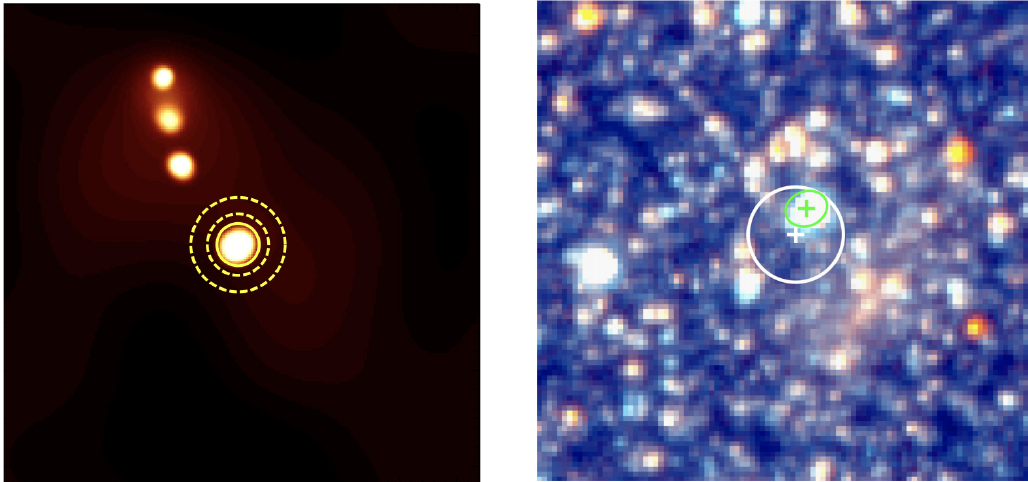
Figure 4. Left : Adapted from Figure 1 in Binder et al. [23], showing the Chandra image of SN 2010da. The yellow circle indicates the location of the X-ray source coincident with SN 2010da (the three fainter sources to the upper-left are unrelated). Right : Figure 2 from Binder et al. [23] showing the Hubble /Advanced Camera for Surveys (ACS) image of the same region. The white cross and circle indicate the location of the X-ray source; the green cross and circle show the location of the likely massive donor